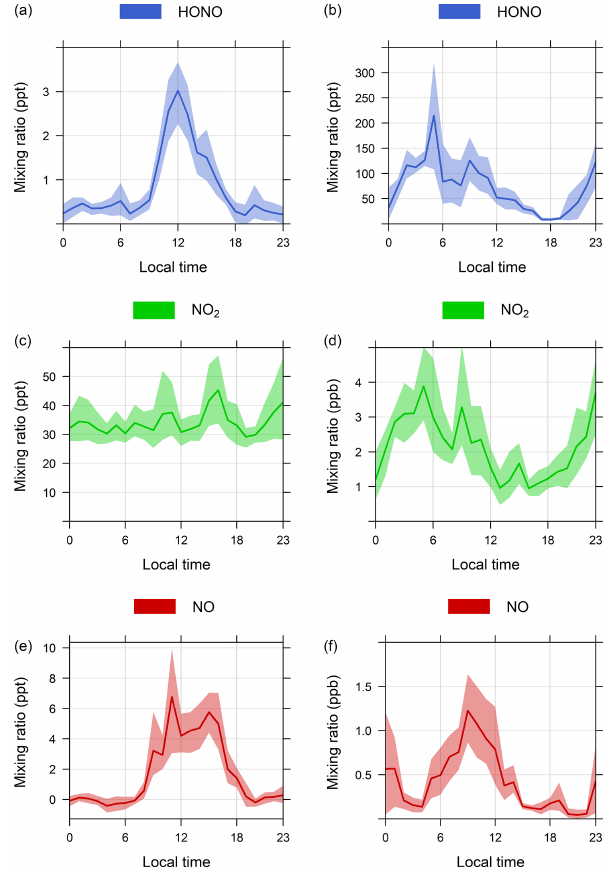
Figure 3. Diurnal profiles of HONO, NO 2 and NO at CVAO (a, c, e) and WAO marine (b, d, f) . Shaded areas represent the 95% confidence intervals of the measurement precision. Note the very different y -axis